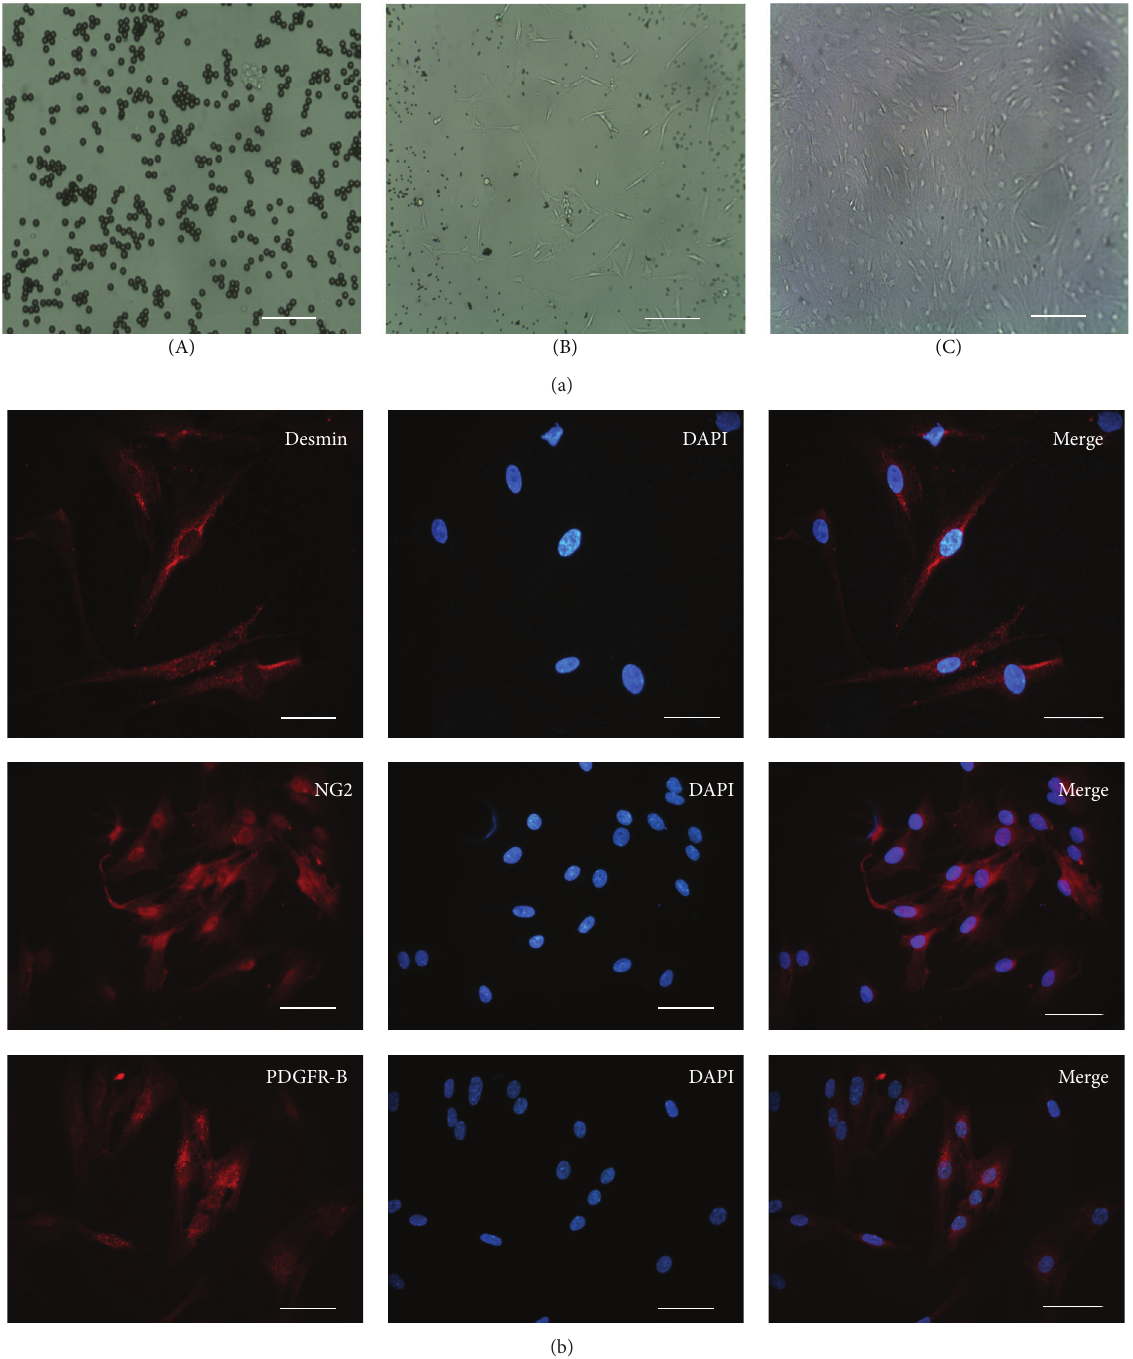
Figure 2: Morphology and immunofluorescent staining were identified in primary rat retinal pericytes. (a) Microscopic image of retinal pericytes, showing cell mass isolated by Dynabeads (A), at 7 days, pericytes got adherence and formed cells cluster (B), at passage 1 non- contact-inhibited growth of pericyte and irregular triangular cell bodies, with thick filaments in the cytoplasm and a plump nucleus (C). Scale bar = 200 𝜇 m. (b) Immunofluorescence staining with anti-desmin, NG2, and PDGFR-B antibody for primary rat retinal pericytes, respectively. Scale bar = 100 𝜇